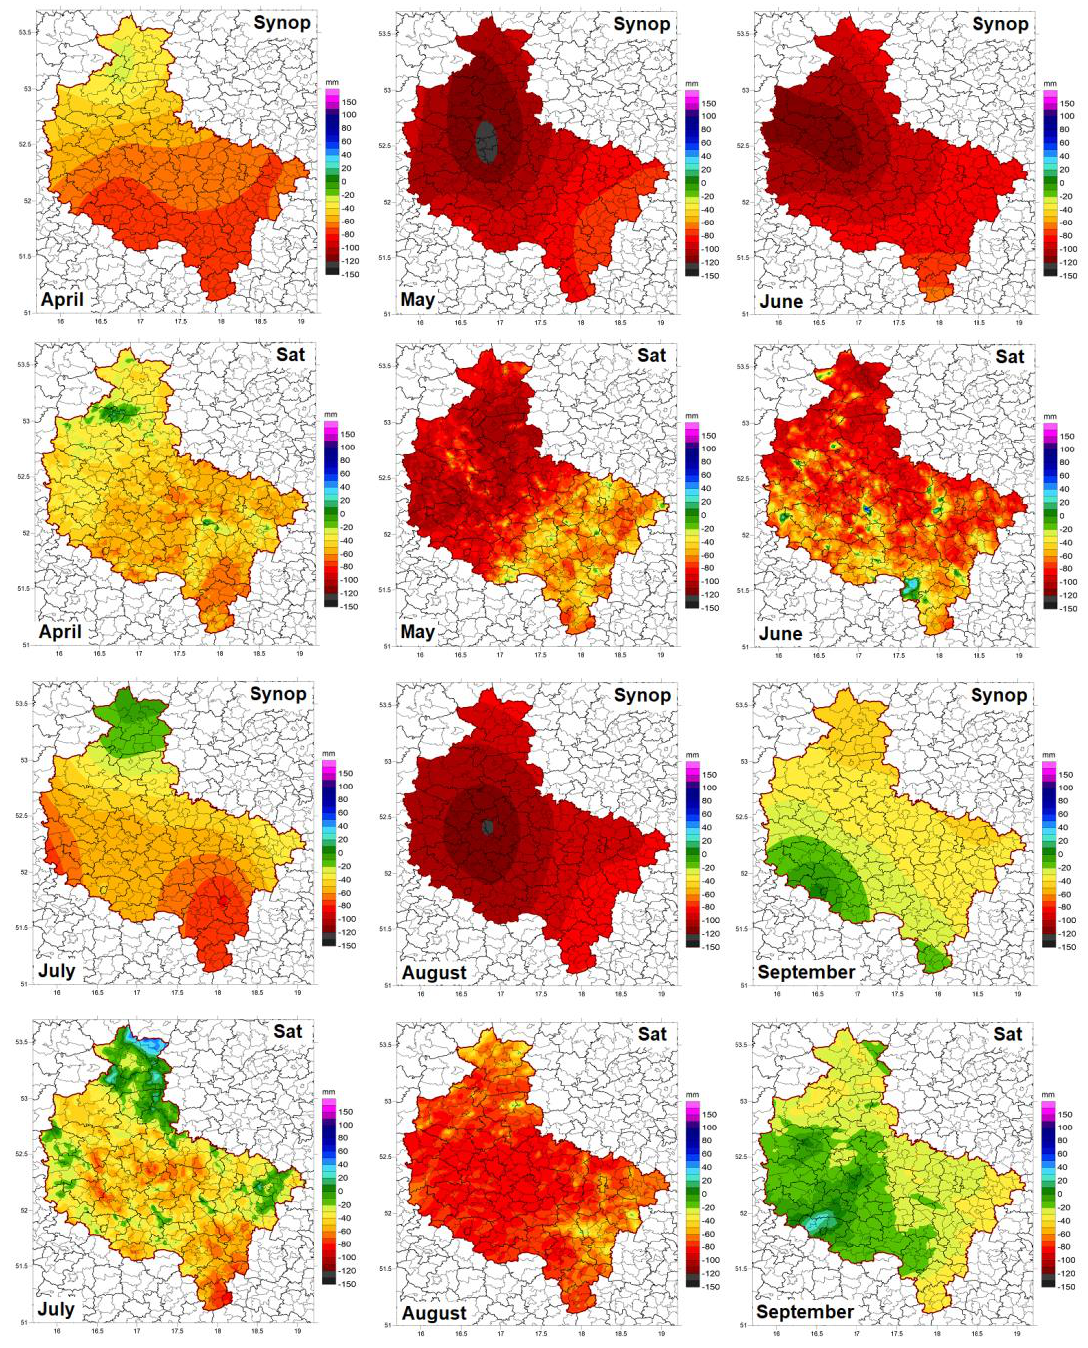
Figure 4. Monthly totals of the Precipitation-Evapotranspiration Index for the growing season of (April–September) 2018, calculated using two methods: based on data from synoptic station (synop) and based on the RainGRS product and evapotranspiration from satellite data (sat) .